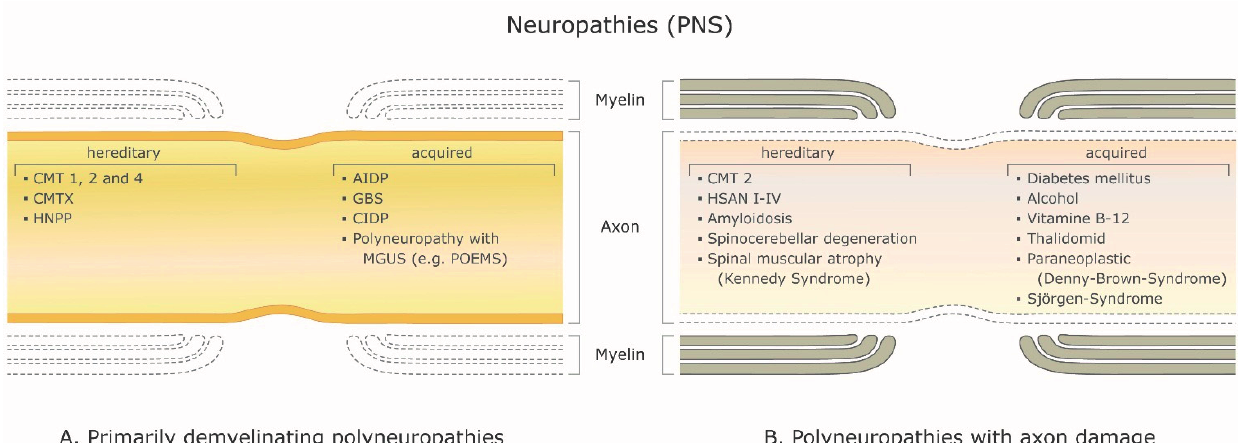
Figure 1. Demyelinating disorders of the peripheral nervous system (PNS). ( A ) Primary demyelinating polyneuropathies and ( B ) Polyneuropathies with axon damage. Abbreviations: CMT 1, 2 and 4: Charcot-Marie-Tooth disease; CMTX: X-linked Charcot-Marie-Tooth disease; HNPP: hereditary neuropathy with liability to pressure palsies; AIDP: acute inflammatory demyelinating polyneuropathy; GBS: Guillain-Barré syndrome. CIDP: chronic inflammatory demyelinating polyneuropathy; MGUS: monoclonal gammopathy of undetermined significance; POEMS: polyneuropathy, organomegaly, endocrinopathy or edema M-protein and skin abnormalities; HSAN I–IV: hereditary sensory and autonomic